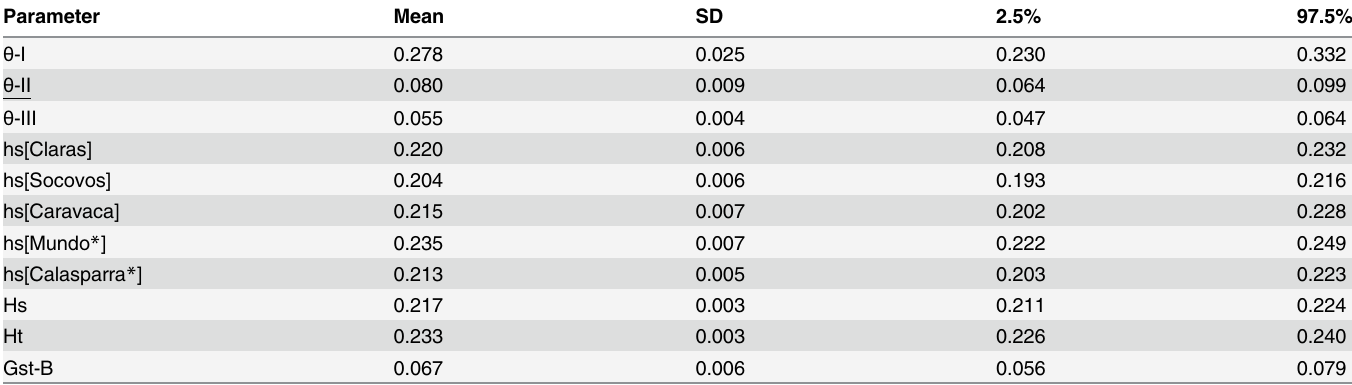
Table 1. Genetic diversity and population subdivision in E . plorans populations from the Segura River basin, provided by Hickory under the f = 0 model. 2.5% and 97.5% constitute the 95% confidence interval.